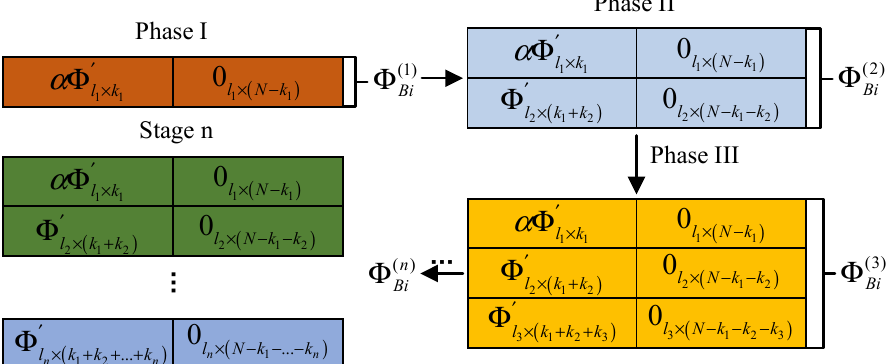
Figure 8. Image coding hidden observation matrix.